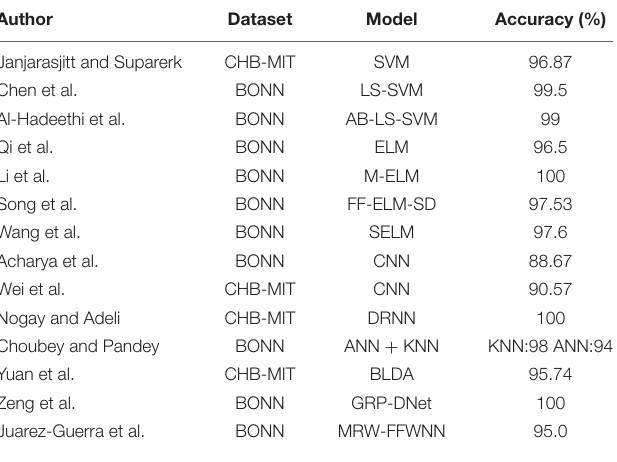
TABLE 1 | Summary of machine learning methods for epilepsy